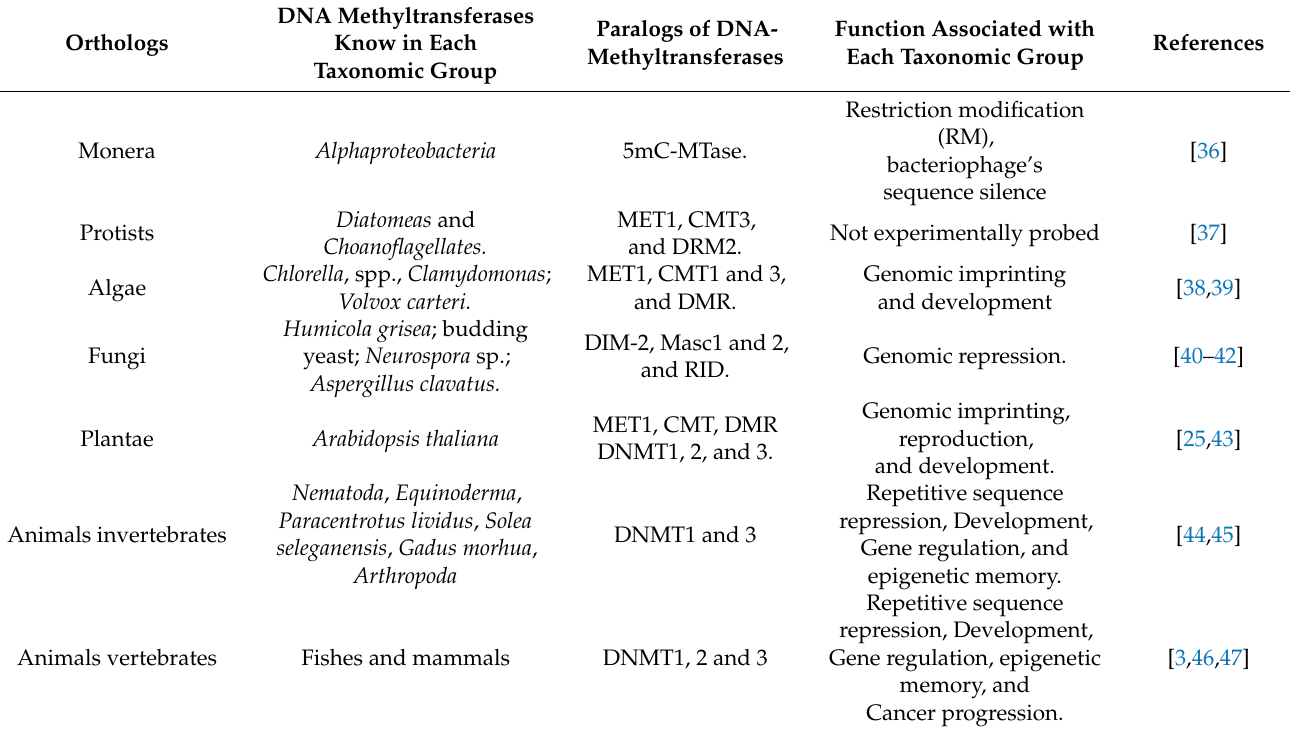
Table 1. DNA methyltransferases (DNMTs) in the five